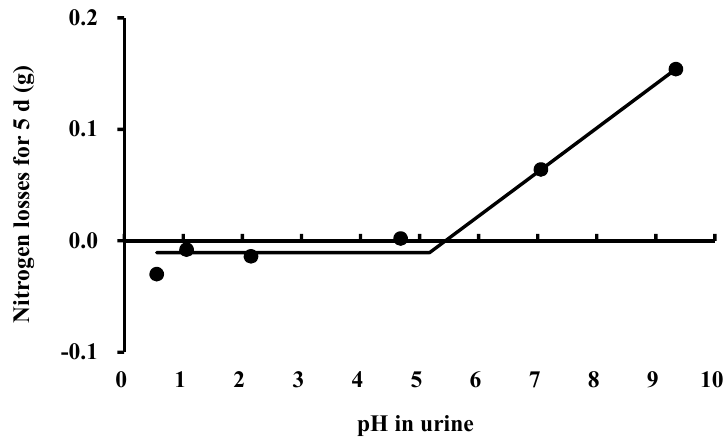
Figure 1. A broken-line analysis of nitrogen losses for 5 d at 6 urine pH values acquired by different inclusion rates of 6 N hydrochloric acid into the 100 mL of each urine sample (Exp. 2). Each data point represents the least squares mean of 3 observations. The amount of nitrogen was 0.53 g on average in 100 mL urine at the beginning. A one-slope broken-line model of nitrogen losses for 5 d indicates that a maximum pH of 5.12 is needed to prevent nitrogen volatilization from the pig urine. The break point was estimated based on following equation: Y = 0.04×(X–5.12)–0.01 where X is more than 5.12 (standard error = 0.712 and p<0.01) in Exp. 2.